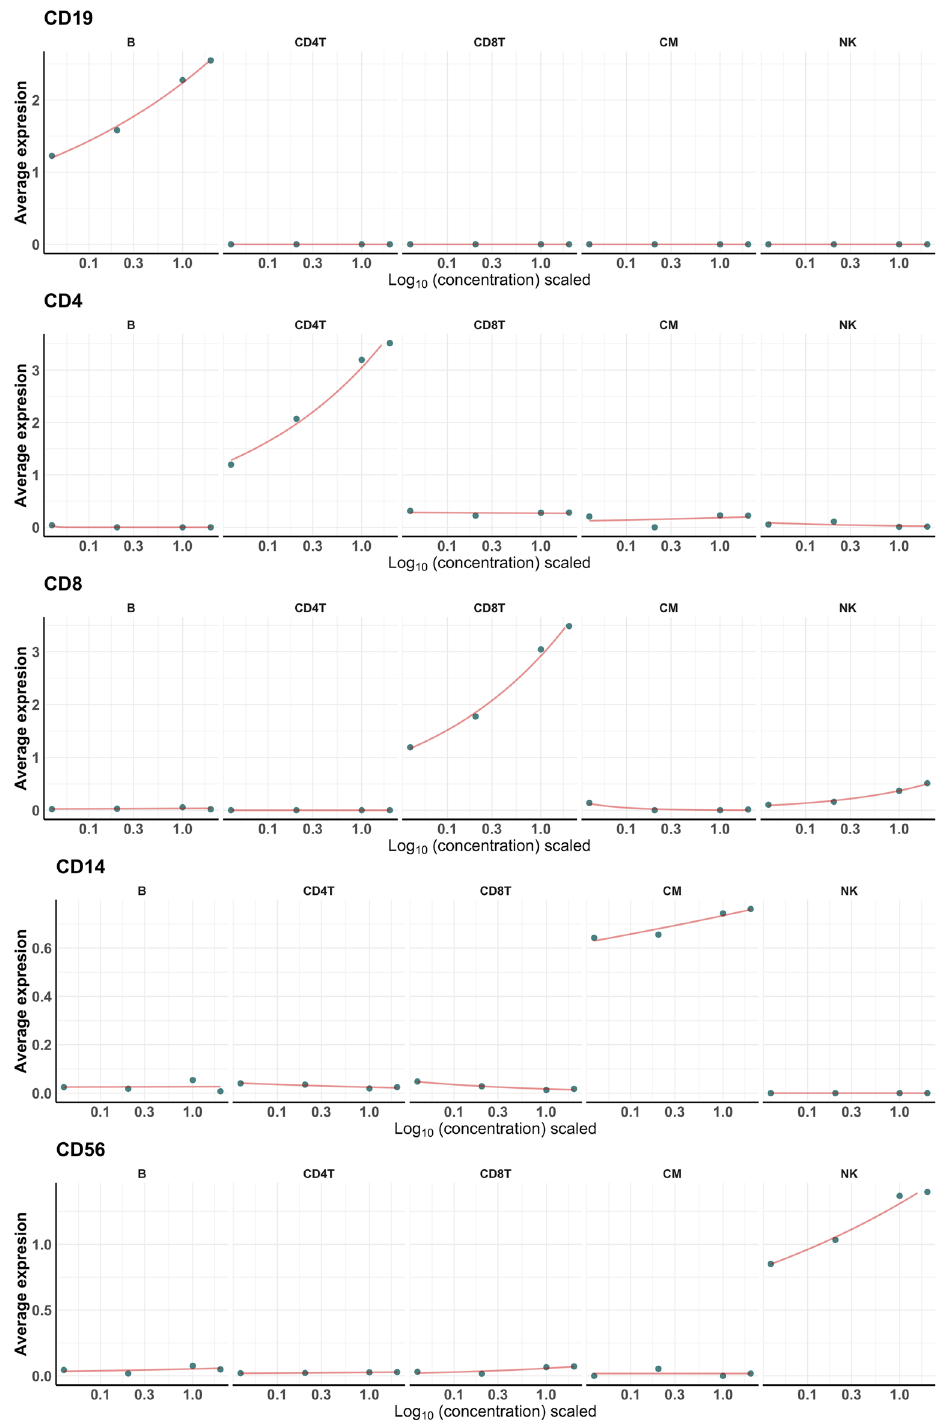
Figure 5. Exemplary dose–response curves. Centered log-ratio (CLR) normalized expression levels of five exemplary surface antigens (CD19, CD4, CD8, CD14, and CD56) at each of the four concentrations in all major cell types. The concentrations (0.04 ×, 0.2 ×, 1 ×, and 2 ×), which were log transformed and scaled by ggplot2’s scale_x_log10 function (lower to higher concentration), are shown on the x axis. The average expression values for each concentration were fit to a Poisson regression model, a type of a generalized linear model (red